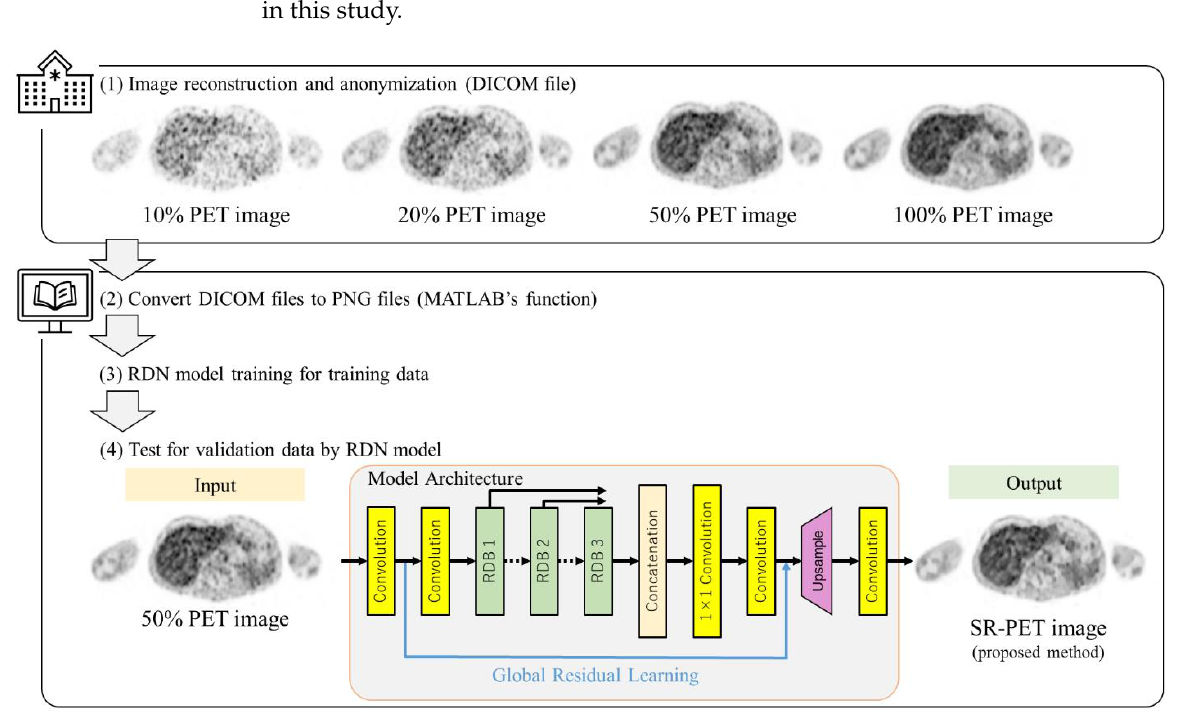
Figure 1. Flow chart of the proposed method and model architecture in this study. DICOM: Digital imaging and communications in medicine, PET: Positron emission tomography, SR-PET: Super-resolved PET, RDN: Residual dense network [30], RDB: Residual dense blocks.